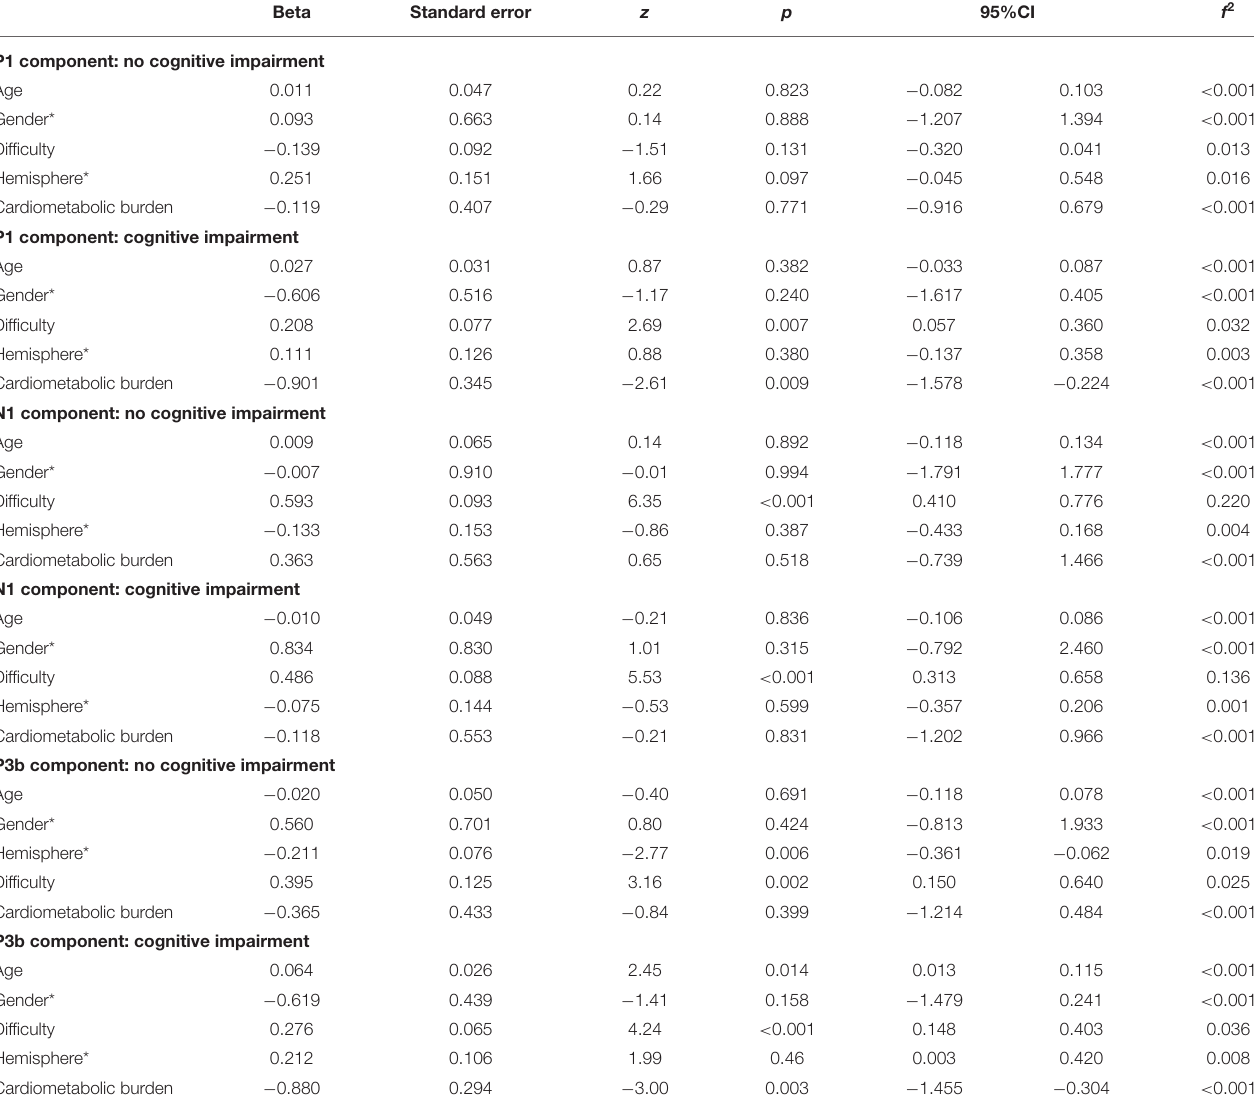
TABLE 5 | Results from mixed effects models for the P1, N1, and P3b ERP component amplitudes stratified by cognitive status (secondary